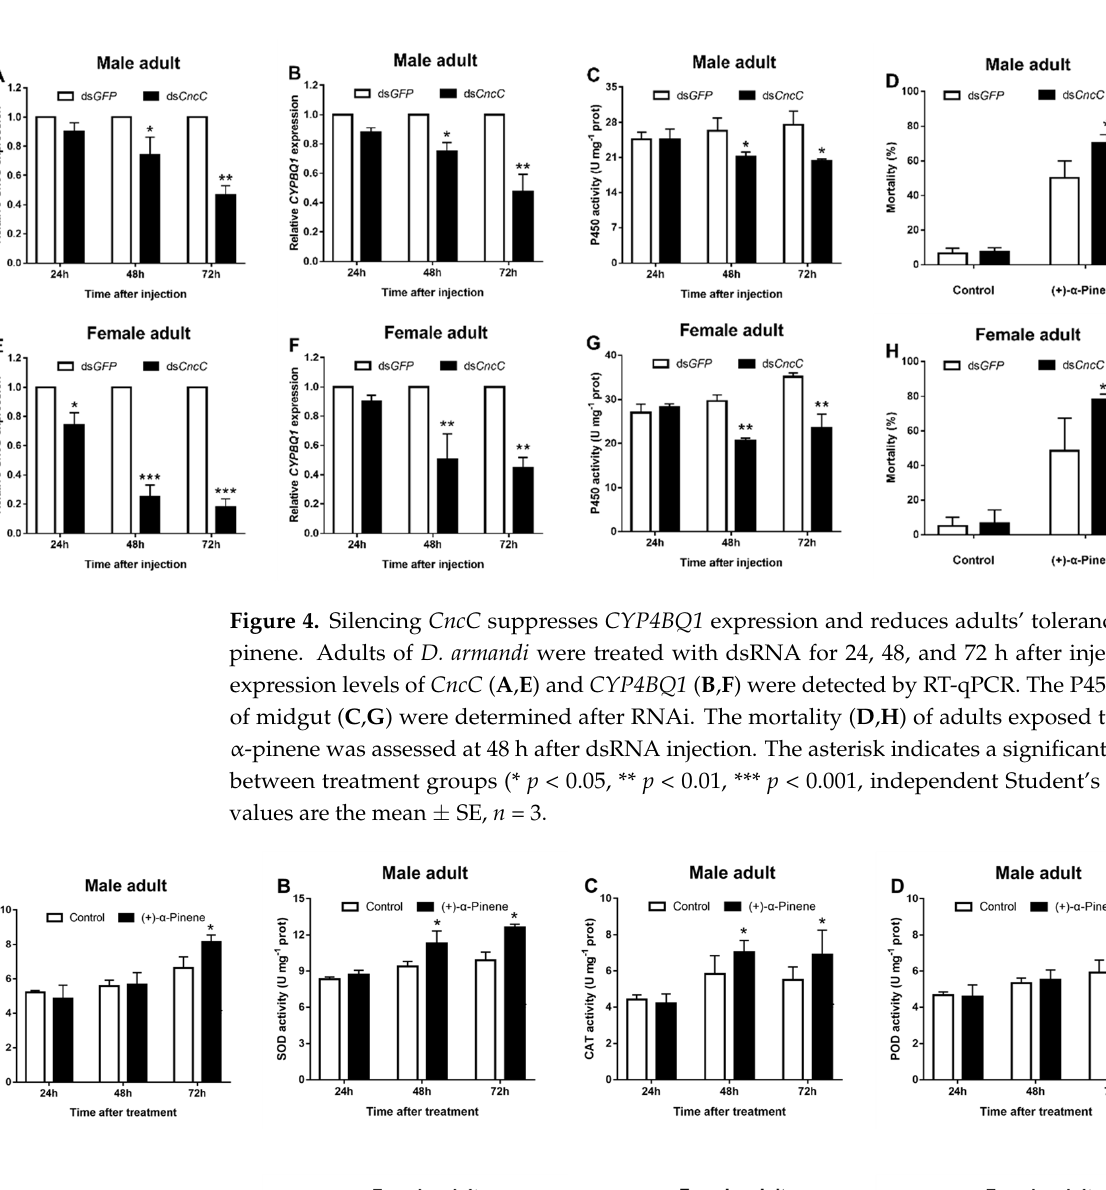
Figure 4. Silencing CncC suppresses CYP4BQ1 expression and reduces adults’ tolerance to (+)- α - pinene. Adults of D. armandi were treated with dsRNA for 24, 48, and 72 h after injection. The ex- pression levels of CncC ( A , E ) and CYP4BQ1 ( B , F ) were detected by RT-qPCR. The P450 activities of midgut ( C , G ) were determined after RNAi. The mortality ( D , H ) of adults exposed to LC 50 (+)- α - pinene was assessed at 48 h after dsRNA injection. The asterisk indicates a significant difference between treatment groups (* p < 0.05, ** p < 0.01, *** p < 0.001, independent Student’s t -test). All values are the mean ± SE, n = 3.